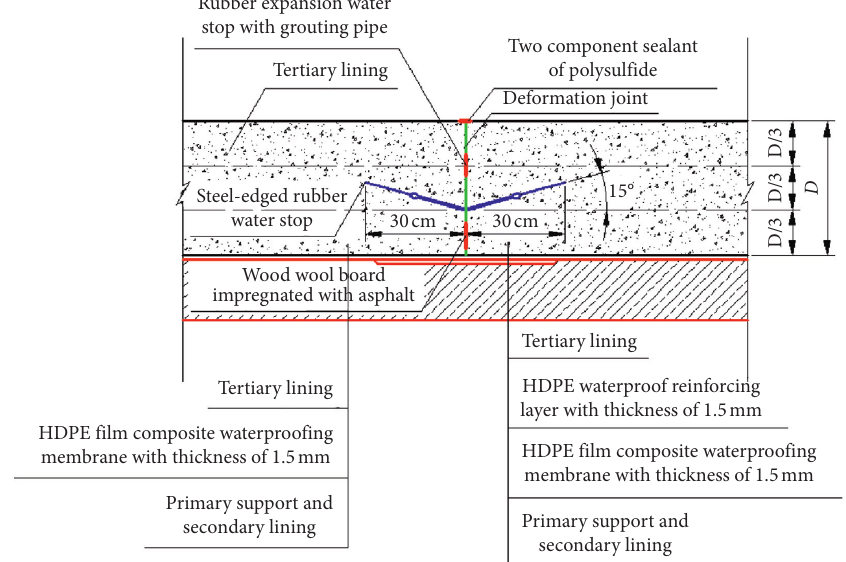
Figure 10: Schematic diagram of the waterproof structure of the deformation